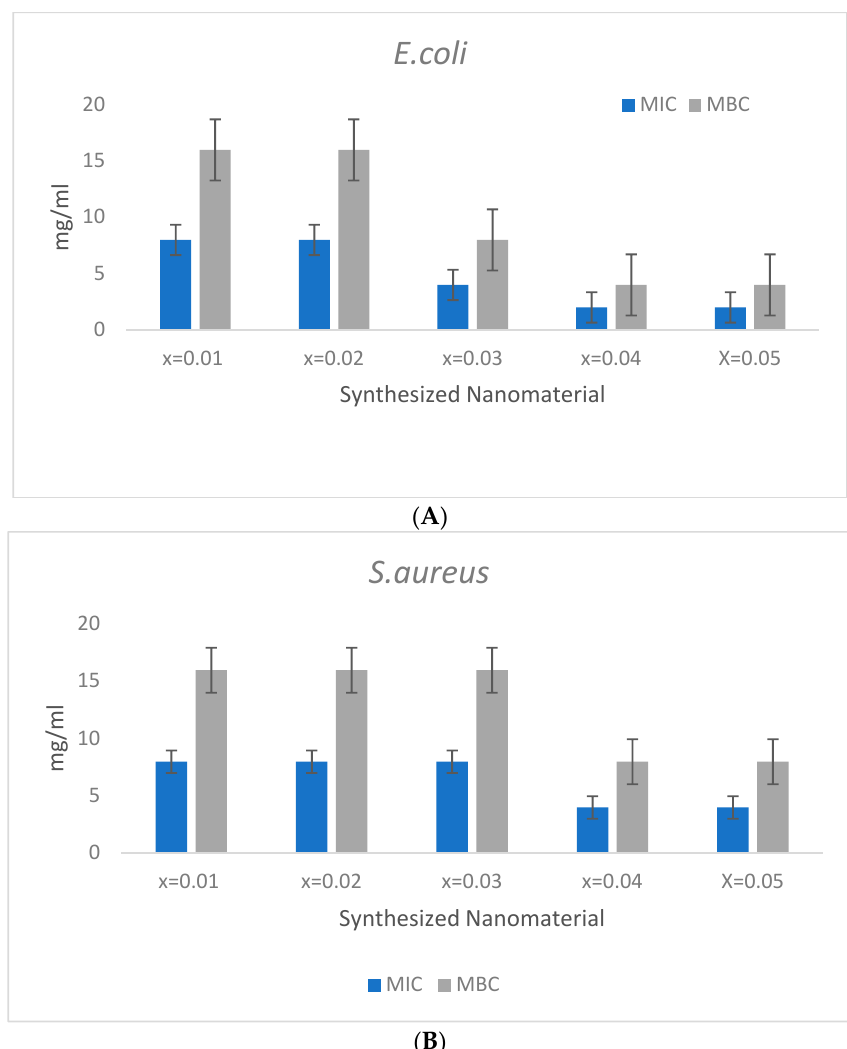
Figure 5. MIC/MBC of Mn 0.5 Zn 0.5 Sm x Eu x Fe 1.8 − 2x O 4 (0.01 ≤ x ≤ 0.05) against ( A ) E. coli ( B ) S. aureus.